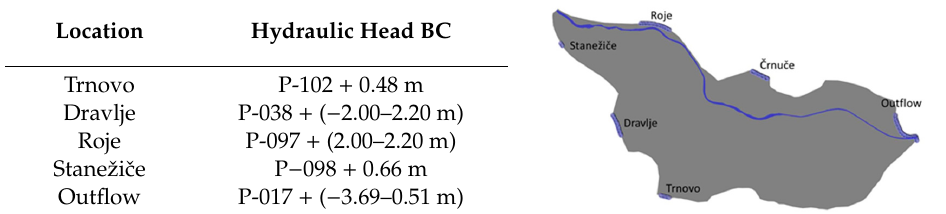
Figure 7. Comparison of the calculated and measured soil moisture [40].